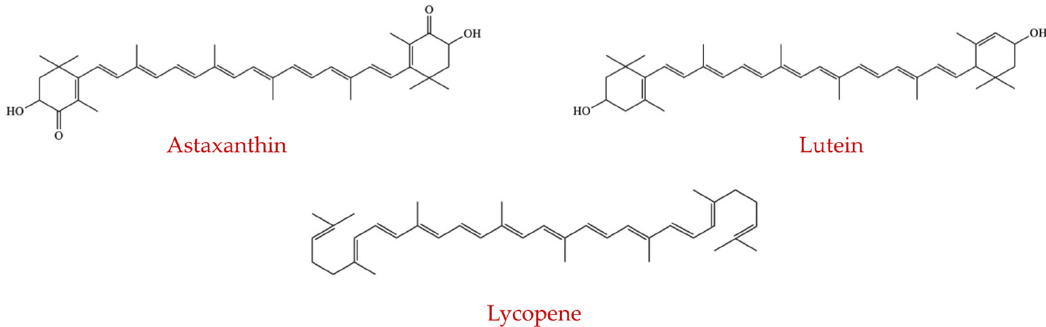
Figure 15. Chemical structures of carotenoids (astaxanthin, lutein, and lycopene) Figure 15 . Chemical structures of carotenoids (astaxanthin, lutein, and lycopene) (self ‐ generated) . Liu et al. (2018) used C57BL/6J mice as a biomedical model for humans to evaluate the intervention of astaxanthin on the gut microflora and to examine its ability to protect against liver injury induced by alcohol. The results showed that astaxanthin treatment notably increased the species from Akkermansia and Verrucomicrobia and reduced species from the genera Parabacteroides , Bilophila , and Butyricimonas and the phyla Proteobacteria and Bacteroidetes in comparison to the mice group fed with ethanol. Furthermore, astaxan ‐ thin supplementation considerably relieves inflammation and reduces the excessive accu ‐ mulation of lipid and serum markers of liver injury [211]. The findings of an in vivo pilot study stated that intestinal microbiota could be altered by 0.04% ( w / w ) dietary astaxanthin at the phylum level by both genotype and gender [204]. Supplementation of astaxanthin selectively decreased the prevalence of colonic Bacteroides and Proteobacteria in female wild ‐ type and BCO2 knockout C57BL/6J mice. Moreover, the population of Bifidobacterium and Actinobacteria significantly increased by astaxanthin only in male wild ‐ type mice, which would result in a favorable effect on gut health. 4.3.2. Lutein Lutein (Figure 15) belongs to the xanthophyll group, and it is an oxygenated carote ‐ noid pigment. Humans and mammals obtain lutein from their diet [212]. In a human phy ‐ totherapy study, two products which contained blackcurrant extract powder, lutein, and lactoferrin were identified to have potential prebiotic actions by remarkably enhancing the abundance of lactobacilli and bifidobacteria, while decreasing other bacterial loads, including Clostridium spp. and Bacteroides spp. [213]. Animals maintained under grazing or rangeland consume a larger amount of lutein over the lifespan than those grown in ‐ doors on formulated rations or feedlot diets. This lutein can be stored in adipose tissue and fat droplets within the muscle tissue of farm animals. It may act as a scavenger of free radical molecules or substances that reduce oxidative damage in the body [212]. 4.3.3. Lycopene Lycopene (Figure 15), one of the primary carotenoids, is a red pigment widely dis ‐ tributed in watermelon, tomatoes, and some other fruits. Wiese et al. (2019) investigated the influence of dark chocolate and lycopene on intestinal microflora, skin, liver metabo ‐ lism, blood, and oxygenation of skeletal muscle tissue. It was found that lycopene com ‐ pounds showed alterations in the composition of colonic microflora by promoting the abundance of beneficial B. longum and B. adolescentis , and was dependent on the dosage level [214]. 5. Mechanism of Action of Phytochemical 5.1. Effect on the Gut Microbiome In general, dietary phytochemicals (polyphenols) are received as xenobiotics in hu ‐ mans once consumed. Their absorption in the small intestine and their biological availa ‐